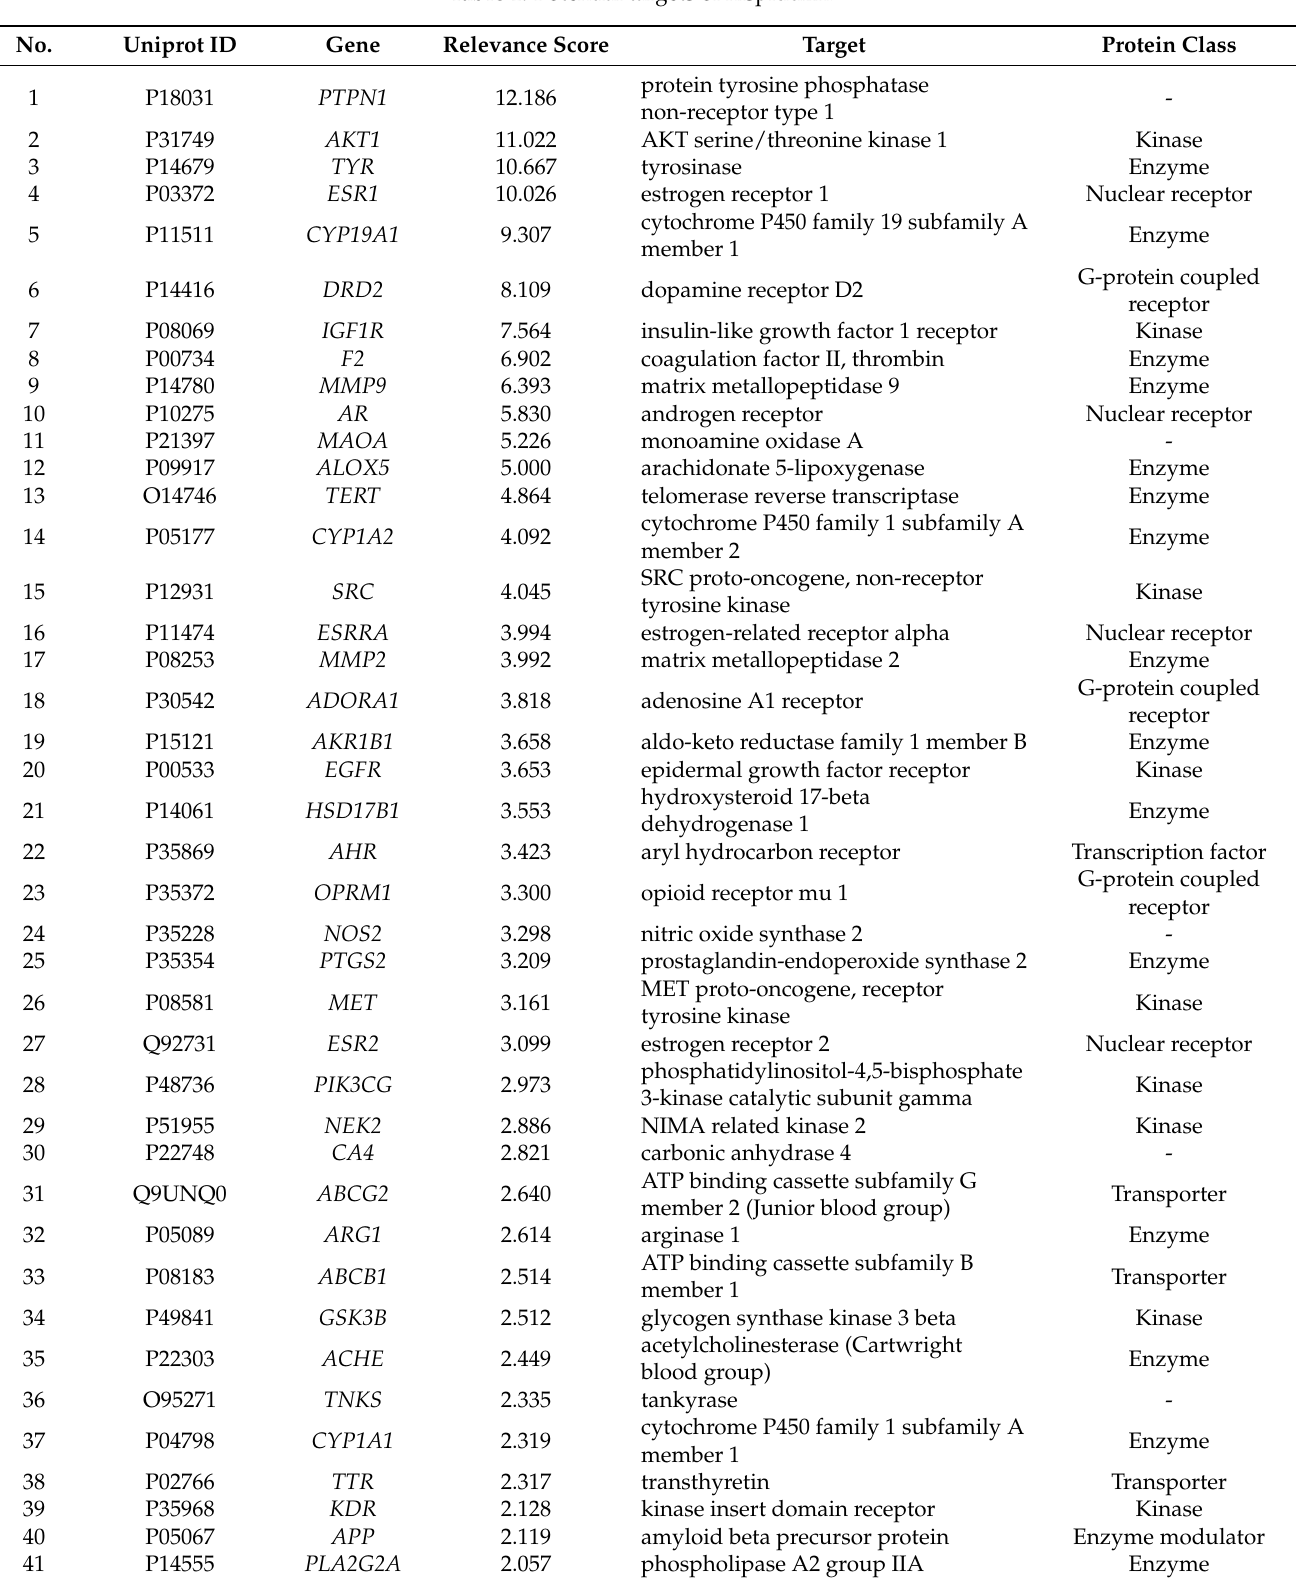
Table 1. Potential targets of